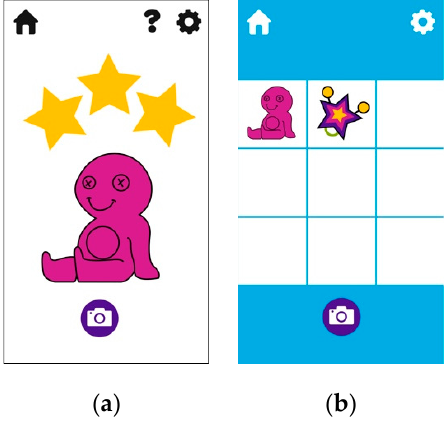
Figure 2. This is the first prototype made to be printed and tested by the specialists: ( a ) basketball